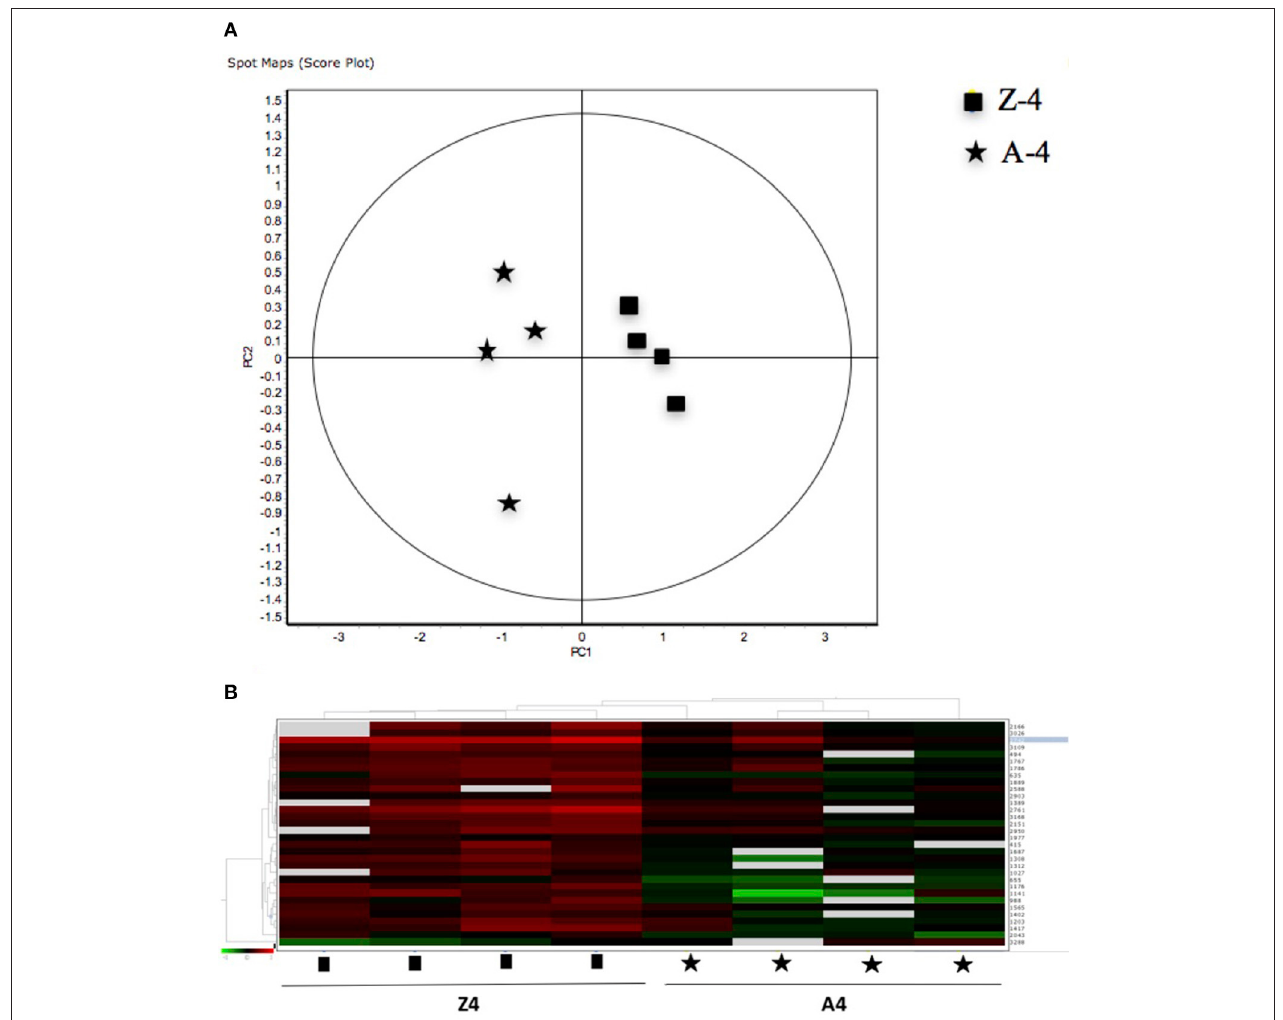
FIGURE 4 | (A) Principal Component Analyses (PCA) and (B) hierarchical cluster analyses of the protein spots (sub-sets) differentially expressed of paralarvae of Octopus vulgaris corresponding to the condition 3 (Z4 vs. A4) considered as function of dietary group and age (details in Supplementary Table 3). % of variance explained: PC1 = 77.1; PC2 =